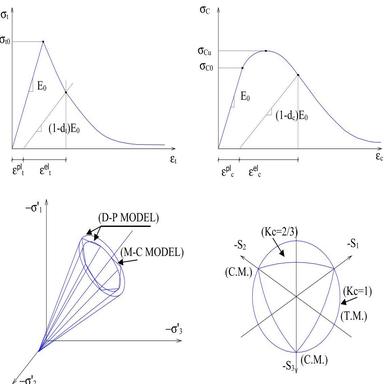
ABAQUS material non-linear behavior in uniaxial tension and compression (top) and modified Drucker–Prager strength domain (bottom).